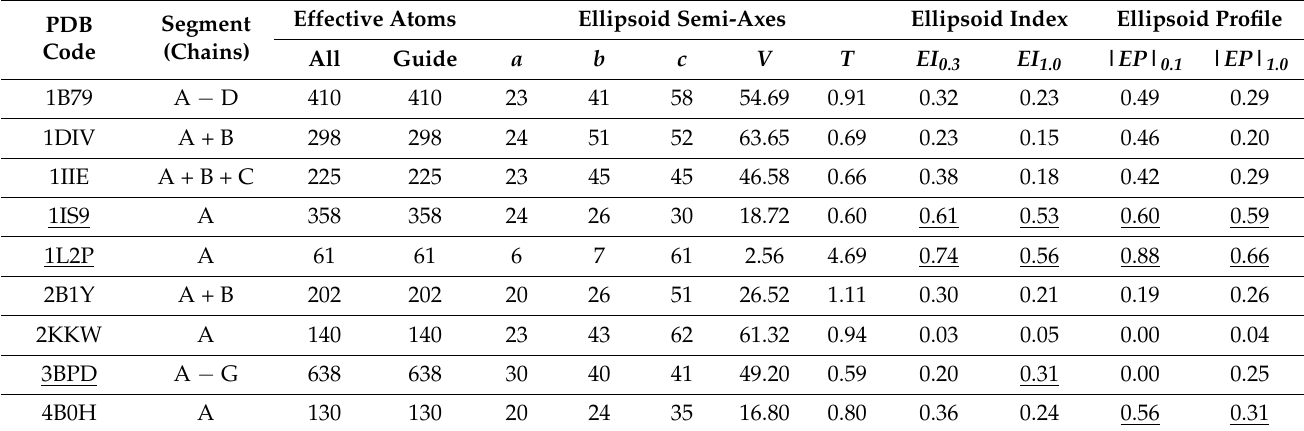
Table 4. Results of application of EP algorithm to selected segments of proteins from Table 1 using m = 0. See description of Table 3 for more information how to interpret this